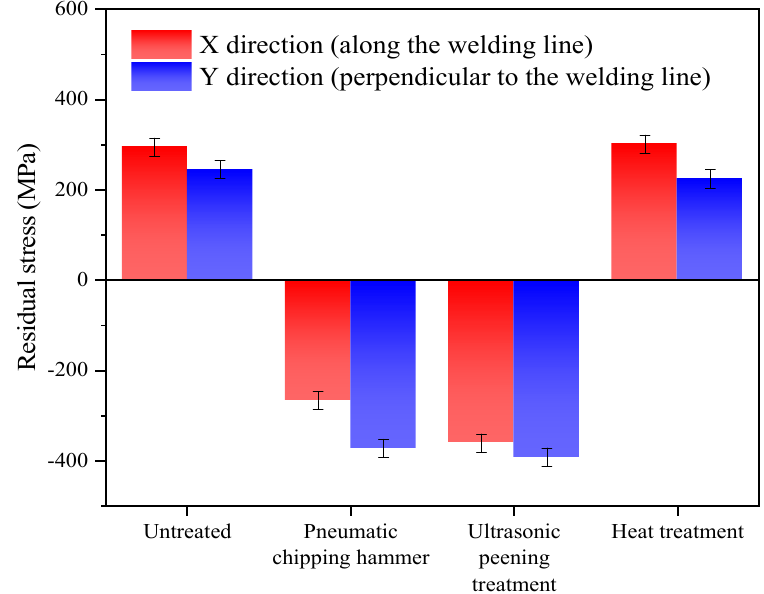
Figure 3. Residual stress of welded joints with different treatments.